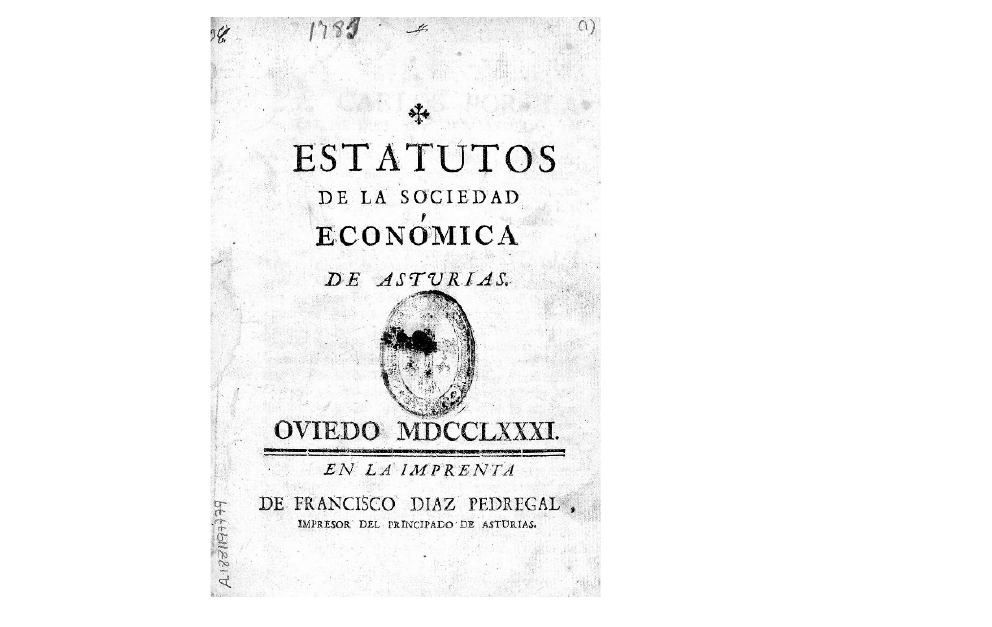
Figure 2. Statutes of the Economic Society of Asturias, 1781 [27].